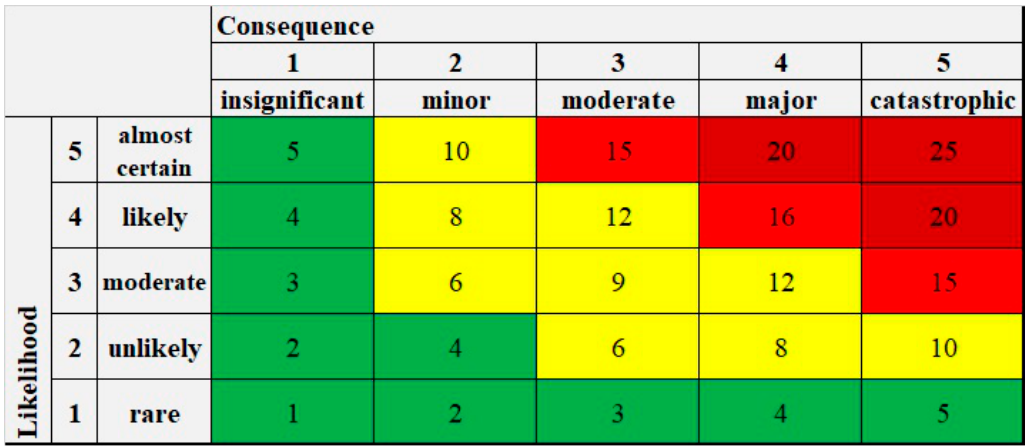
Table 2. Environmental impact and risk resulting from CBM exploitation.